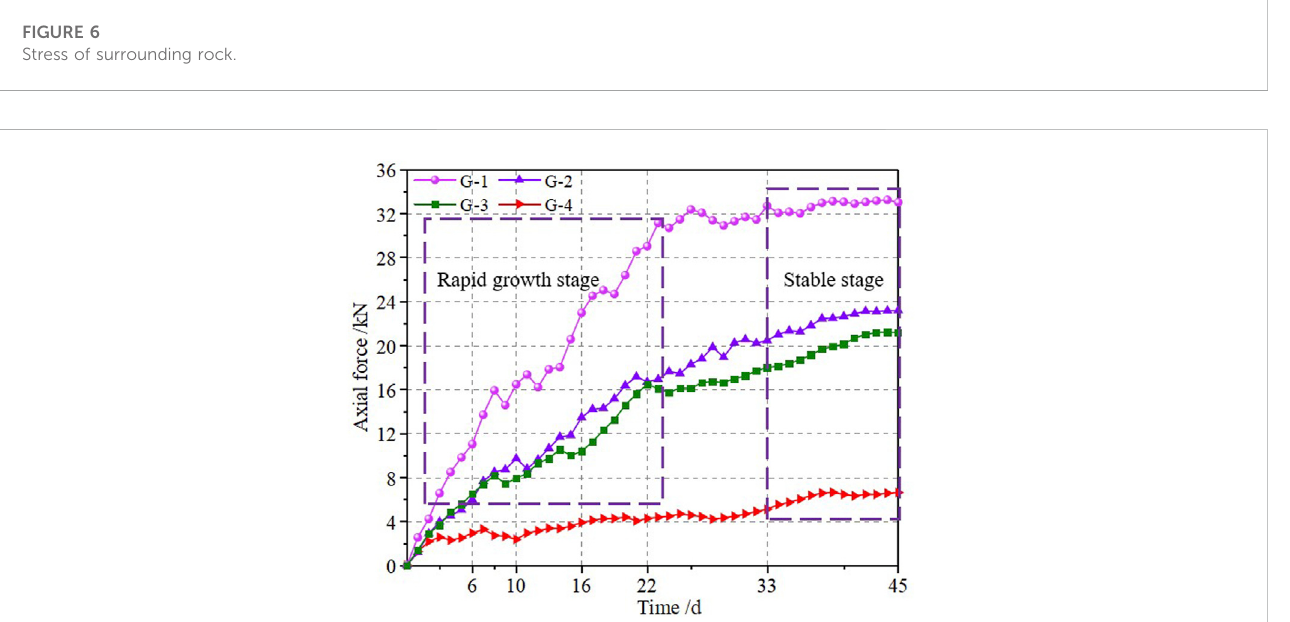
FIGURE 7 Axial force of the steel arch